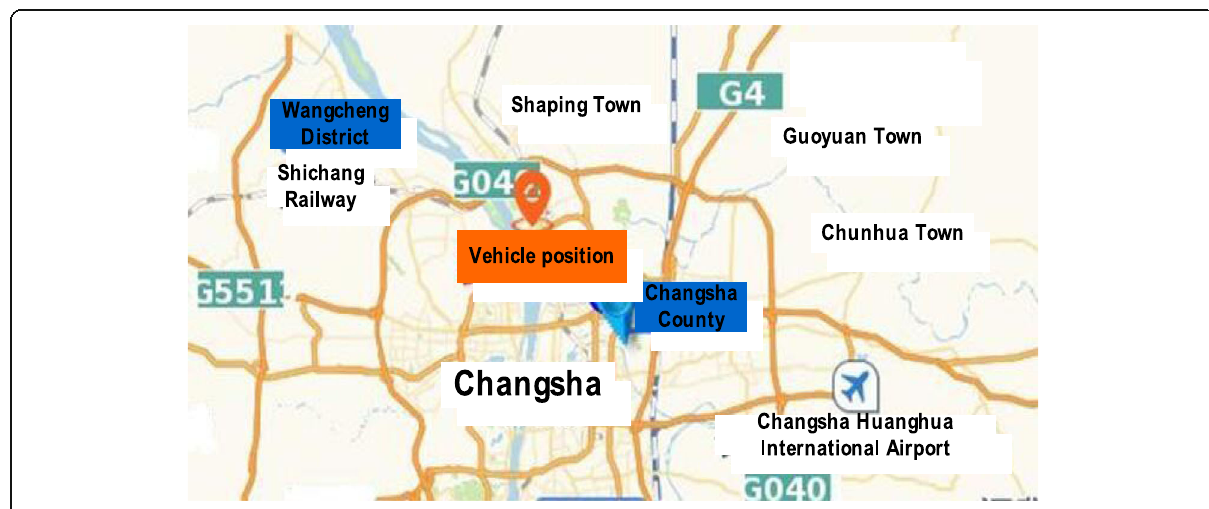
Fig. 9 APP monitoring